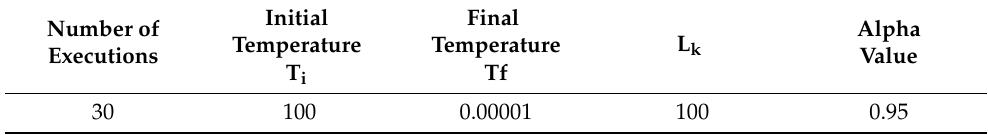
Table 2. Tuning parameters for TAIPO and SAIPO algorithms.